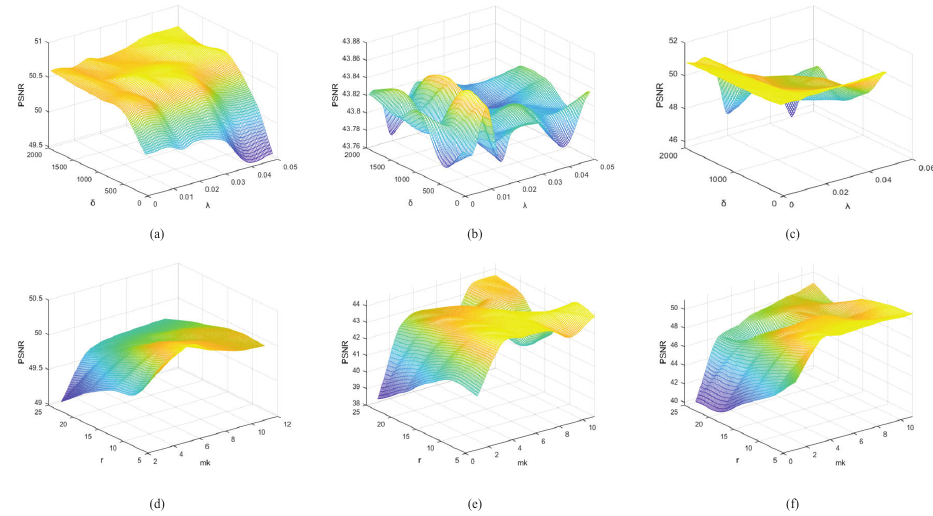
Figure 11. The first row shows the psnr as a function of parameter λ and parameter δ on three data sets. The second row shows the psnr as a function of parameter m k and parameter r on three data